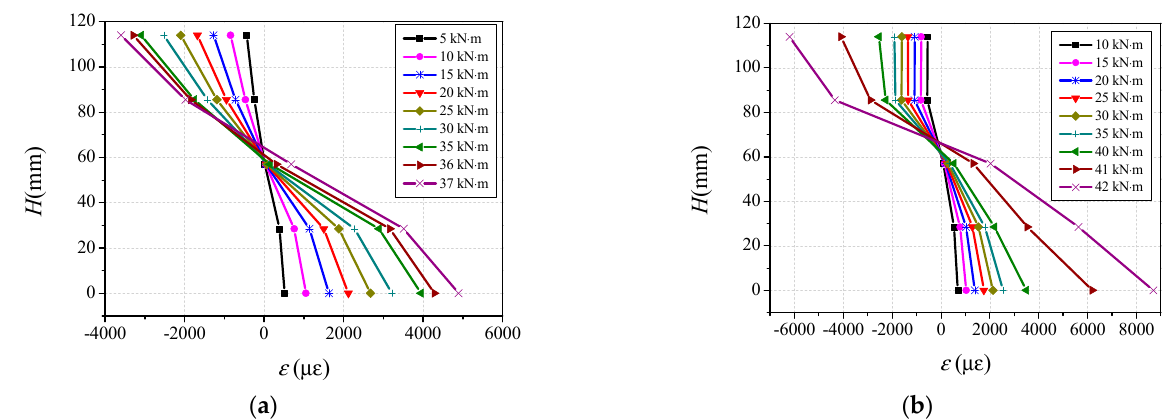
Figure 9. Typical longitudinal strain distribution along the sectional height of the specimen. ( a ) BC32S6; ( b ) BC32S10.